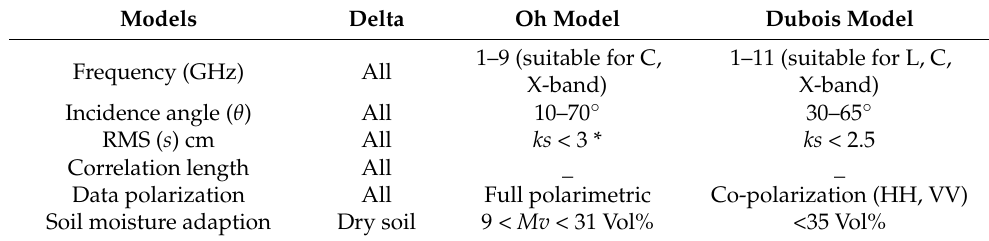
Table 1. Comparison between the backscattering models in different natural surface conditions. Models Delta Oh Model Dubois Model Frequency (GHz)